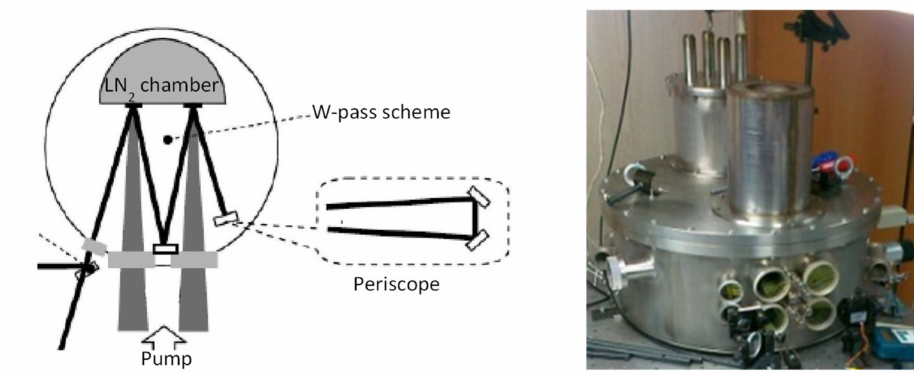
Figure 11. Optical scheme and a photograph of vacuum cryostat of a multipass cryogenic amplifier based on Yb:YAG